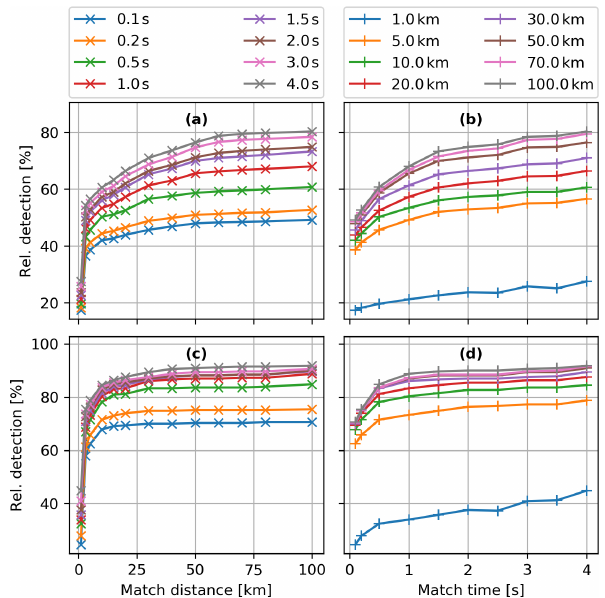
Figure 4. Relative detection efficiency based on constant, equal time criterion d t match (line color) with varying distance d s match for ISS-LIS (a) and Meteorage (c) . Panels (b) and (d) are with constant, equal distance d s match (line color) and varying d t match for ISS-LIS and Meteorage,